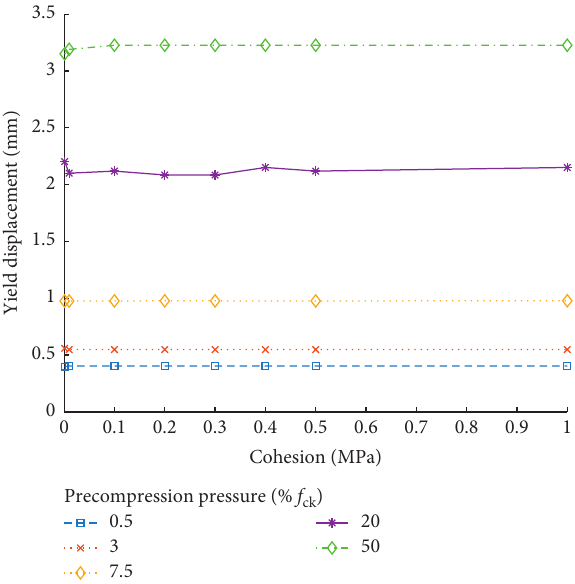
Figure 19: Yield displacement vs cohesion for varying pre- compression